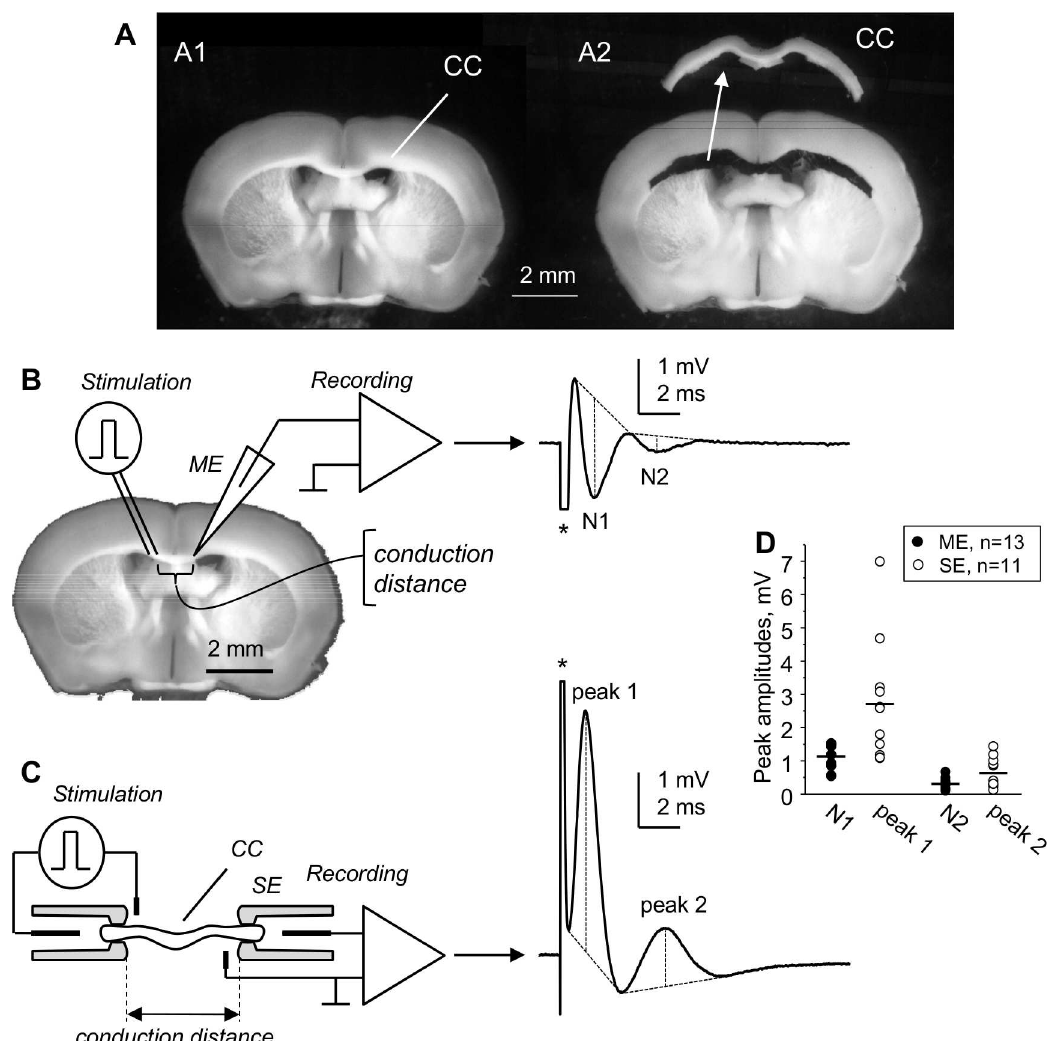
Fig 1. The isolated corpus callosum (CC) for suction electrode (SE) recording of compound action potentials (CAPs). (A) 400 μ m-thick coronalslice of mouse brain before (A1) and after (A2) dissectingout the CC. The isolated CC is shown in A2 above the slice. (B) Field microelectrode (ME) recordingof CC CAPs within brain slices, showingtwo negativepeaks conventionally referred to as N1 and N2. (C) Our novel “whole” CC recordingof CAPs from isolatedCC using SE stimulationand recording,showingtwo positive peaks 1 and 2. The CAPs in B and C were maximal and were averaged from 6 consecutive traces taken at 10 s intervals. Stimulus artifacts are marked with ( * ) in (B) and (C). Dashed lines on CAPs explainthe measurements of peak amplitudesfrom their projected bases. (D) Amplitudesof CAP peaks recorded at 1.5–2 mm conductiondistances in different slices using ME (black circles) or in isolatedCCs using SE (open circles) at room temperature. Horizontalbars in (D) indicate mean amplitudes of ME and SE recordedCAP peaks. Note larger amplitudes of SE-recorded “whole” CC CAP peaks comparedto ME recordings. The “whole” CC SE recording more adequatelycharacterizes the axonalpopulationof CC spanning betweenthe stimulatedand recordedsites comparedto ME